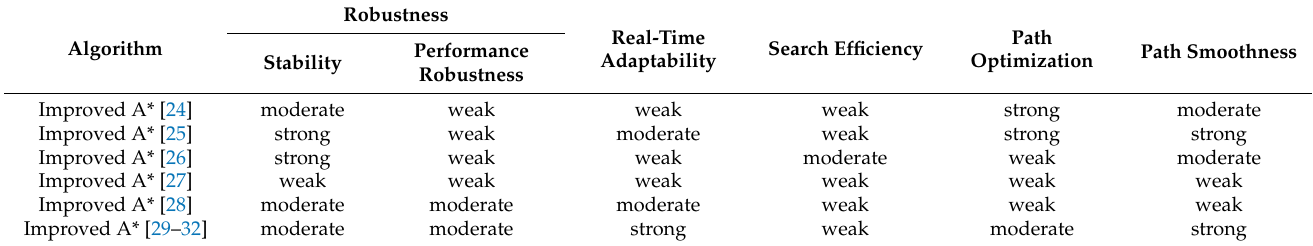
Table 1. Performance comparison of several improved A* algorithms in the